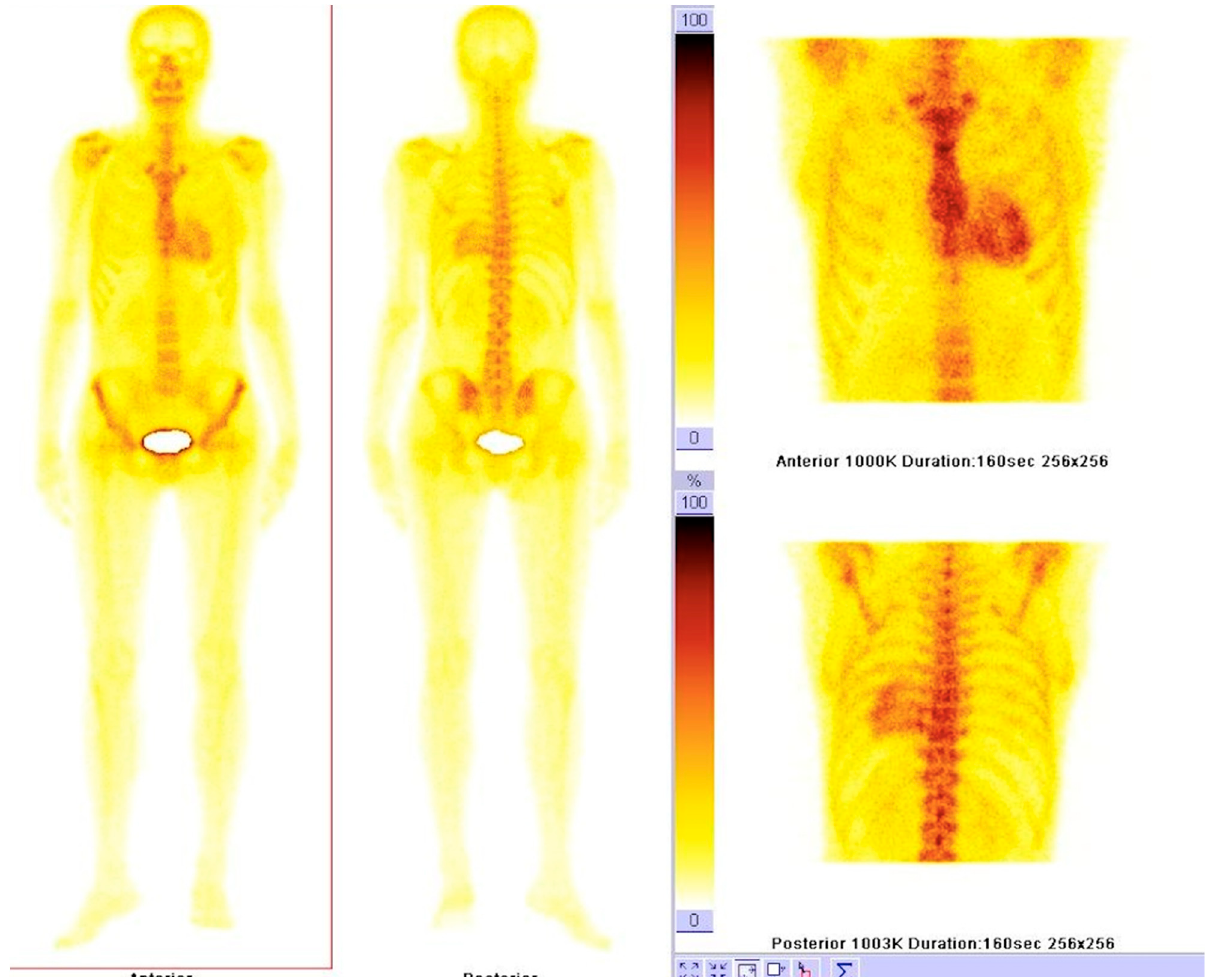
Figure 6. Bone scintigraphy with Technetium-99m hydroxymethylene diphosphonate illustrating abnormal myocardial uptake (Perugini grade 3) in a young woman with transthyretin amyloid cardiomyopathy.